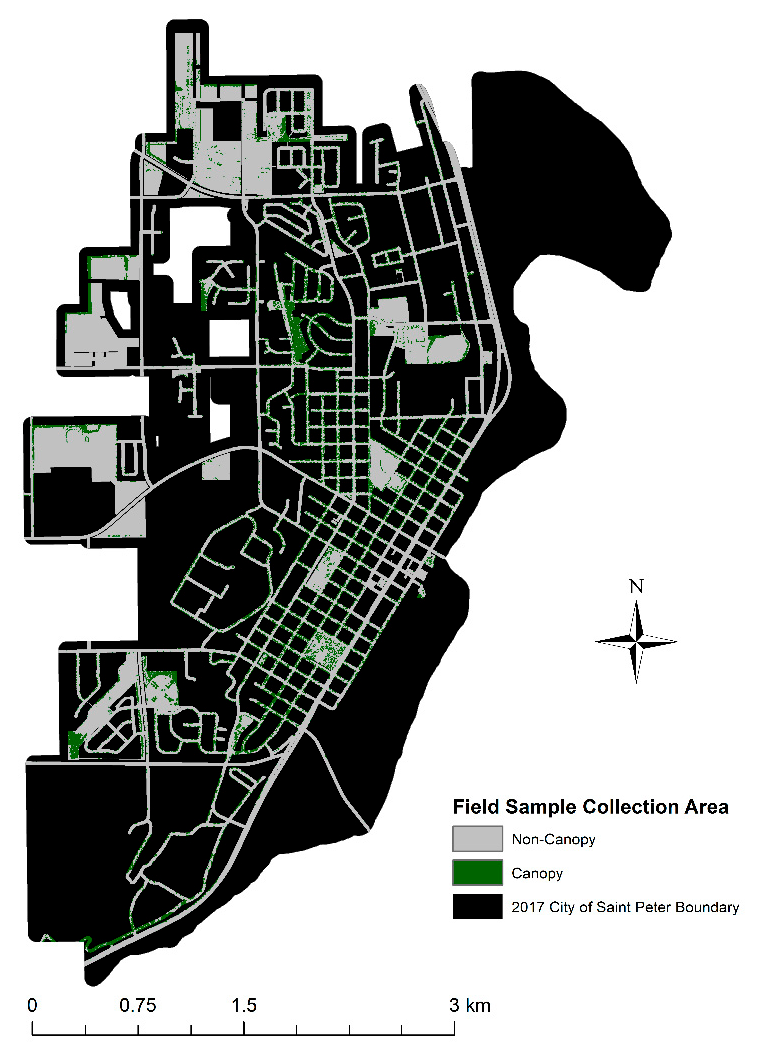
Figure 3. Map of field sample collection area within the City of St Peter.